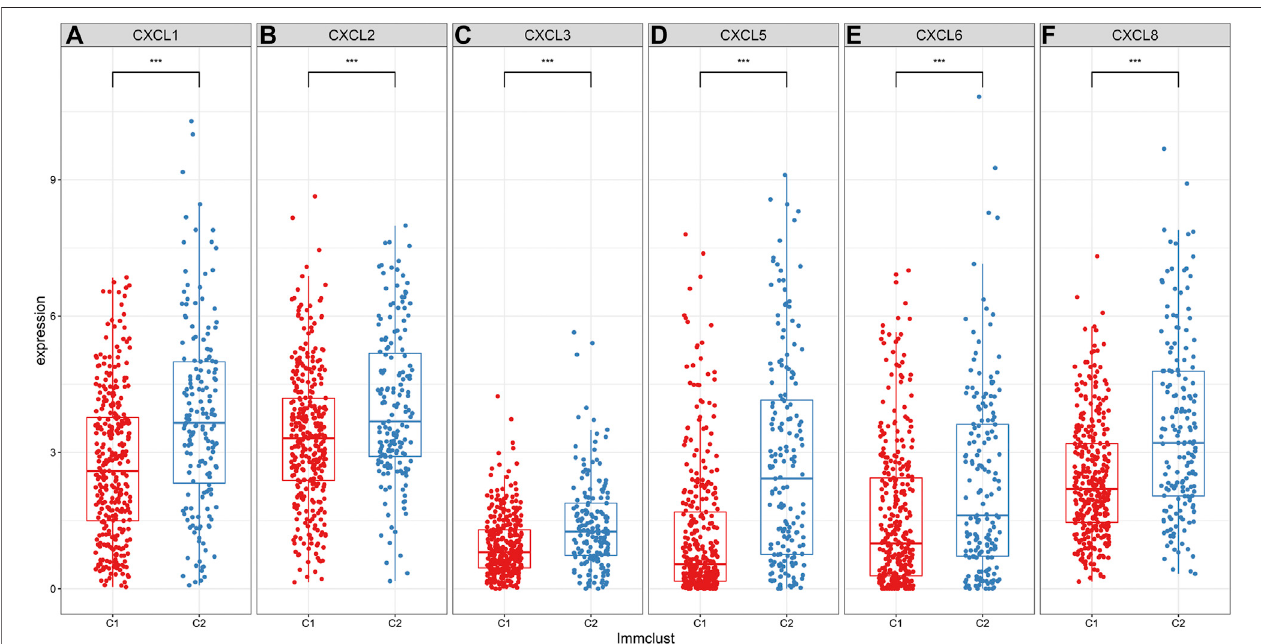
FIGURE4| Differences inexpression patternsofCXCchemokinesbetweentwoccRCC molecular subtypes. Asdepictedinthebox plots,theexpression levelsof (A) CXCL1 (B) CXCL2 (C) CXCL3 (D) CXCL5 (E) CXCL6 and (F) CXCL8 are visualized in ccRCC samples between C1 and C2. *** p < 0.001.